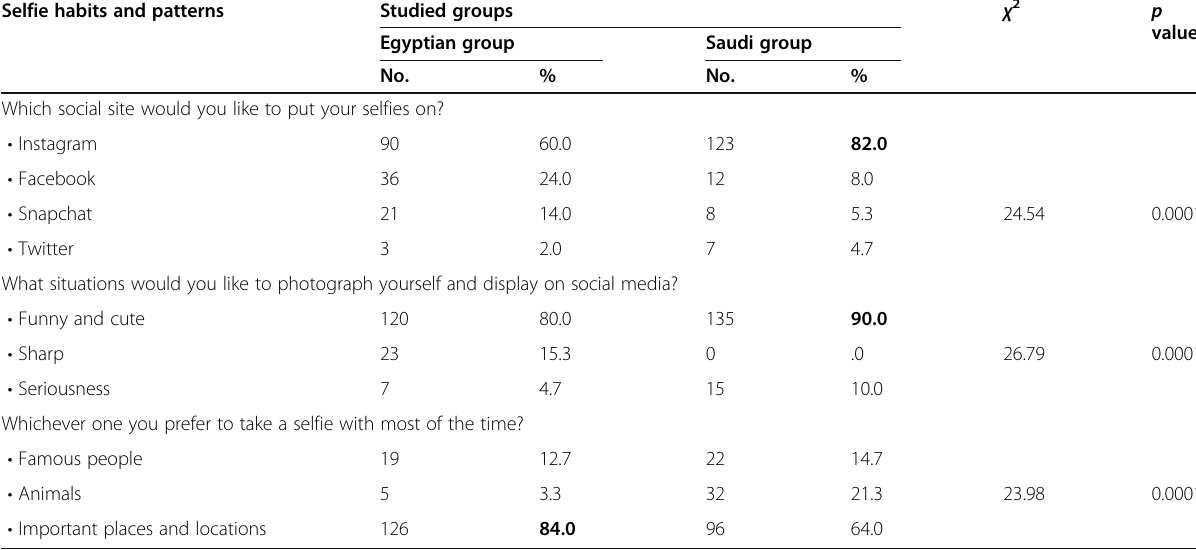
Table 2 Comparison between Egyptian and Saudi nursing students as regard selfie habits and patterns (each group n = 150) (Continued) Selfie habits and patterns Studied groups χ